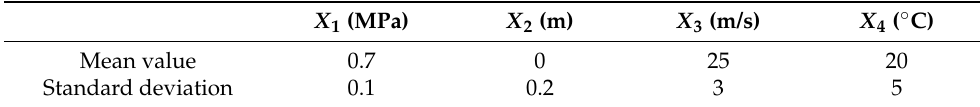
Table 4. Mean values and standard deviations of random